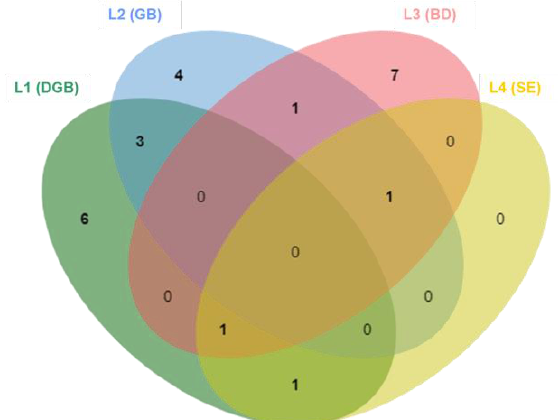
Figure 2. Venn diagram showing the number of shared and exclusive species between samples.